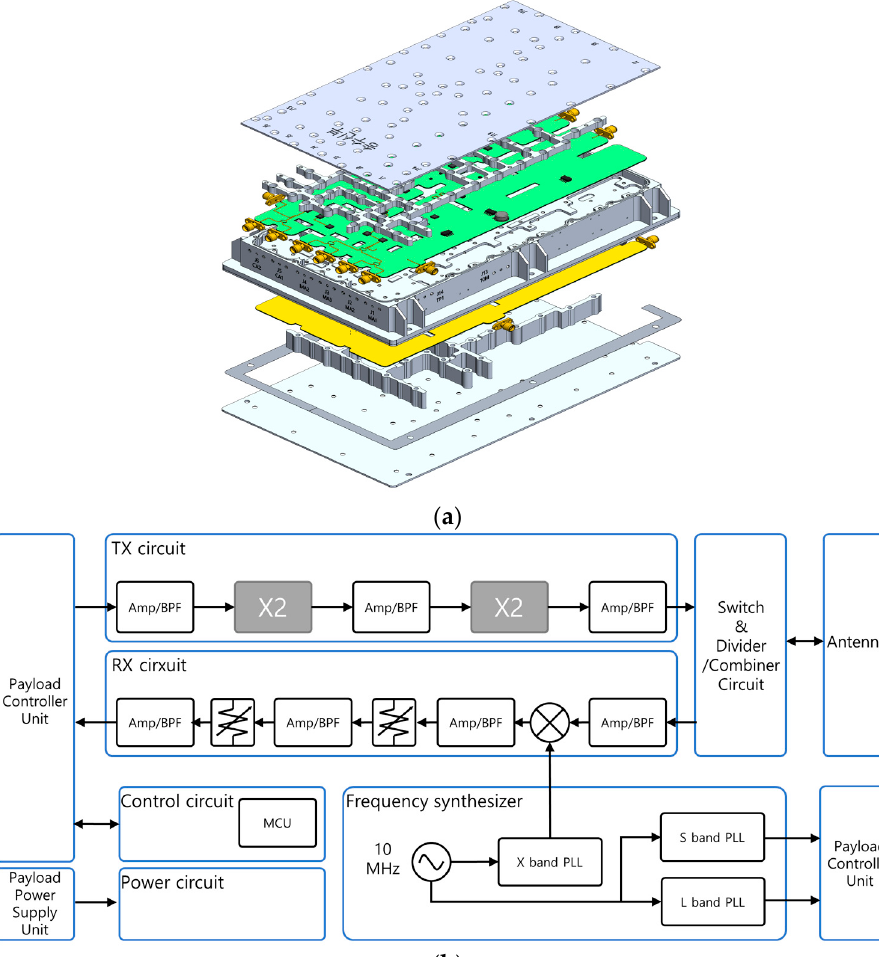
Figure 13. ( a ) Exploded view and ( b ) architectural block diagram of the S-STEP RFU. In particular, the five circuits in the transceiver were integrated into a single module to reduce the weight to suitable limits for a miniature SAR satellite. An expanded view of the integrated module of the S-STEP RFU is presented in Figure 13a. A PCB with inte- grated transmit and receive functions and a PCB with frequency synthesis and control functions were fastened to the upper and lower surfaces of the double-sided machined housing, respectively. Moreover, bulkheads were used for the internal electromagnetic shielding. Heat dissipation and material selection are crucial for withstanding the space envi- ronment. Thus, a thermal pad was applied between the housing and bottom to dissipate heat to the bottom, and a PCB base satisfying the outgassing standard was selected. Ad- ditionally, the inner surface of the housing was treated with chromate and the outer sur- face was treated with black anodizing to prevent corrosion. 4.3. Digital Control Unit As depicted in Figure 14, the implemented DCU had a mass of 0.9 kg and DC power consumption of 35 W. The external and internal configurations of the DCU are presented